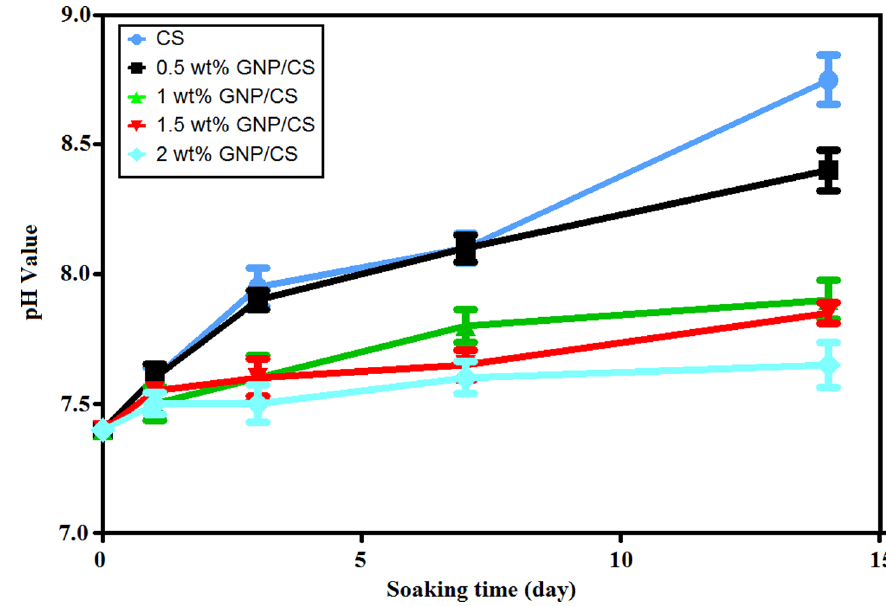
Figure 9. The change of pH value in SBF solution after soaking for various time periods.